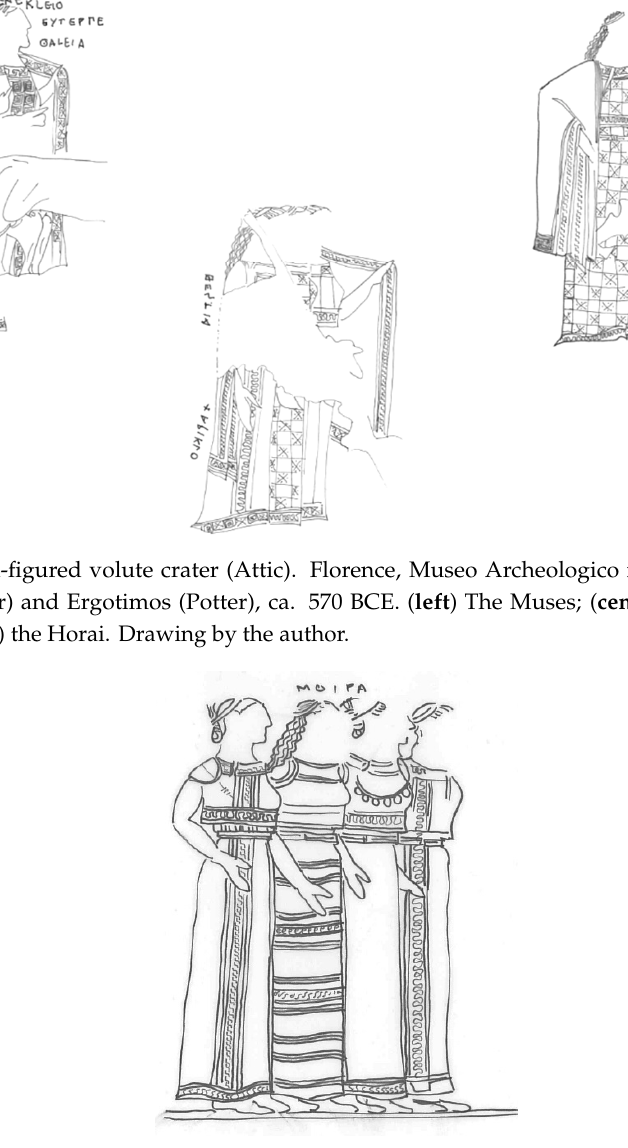
Figure 5. The Moirai. Black-figured volute crater (Attic). Florence Museo Archeologico etrusco inv. 4209. Signed by Kleitias (painter) and Ergotimos (Potter), ca. 570 BCE. Drawing by the author.